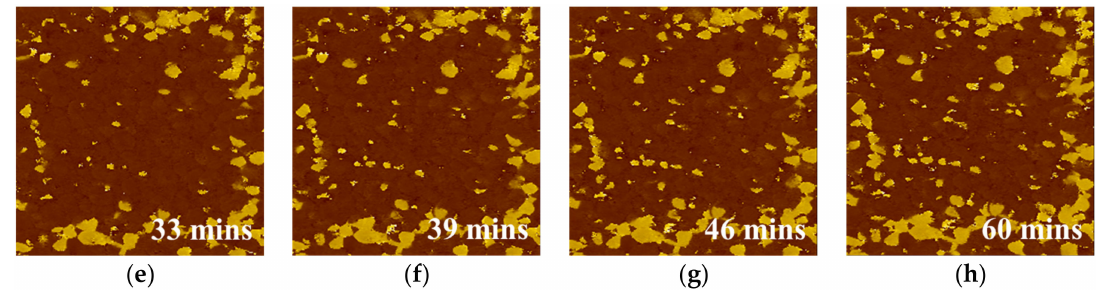
Figure 4. The ( a ) topography image of BFMO film with the deposition oxygen pressure of 2 Pa; ( b – h ) The corresponding out-of-plane piezoresponse phase images after depolarized with +11 V voltage with the tip earthed for different periods of time.